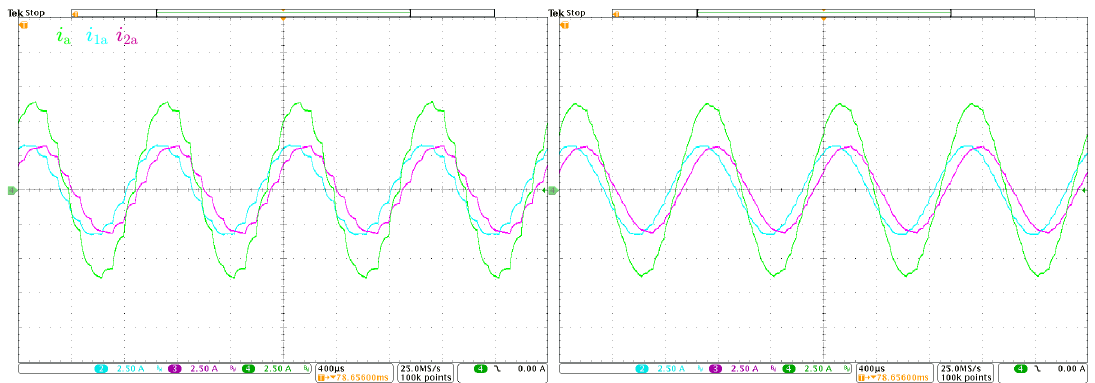
Figure 18. Phase currents of component inverters and the corresponding load currents of the modular VSI with two-level ( left ) and three-level ( right ) component